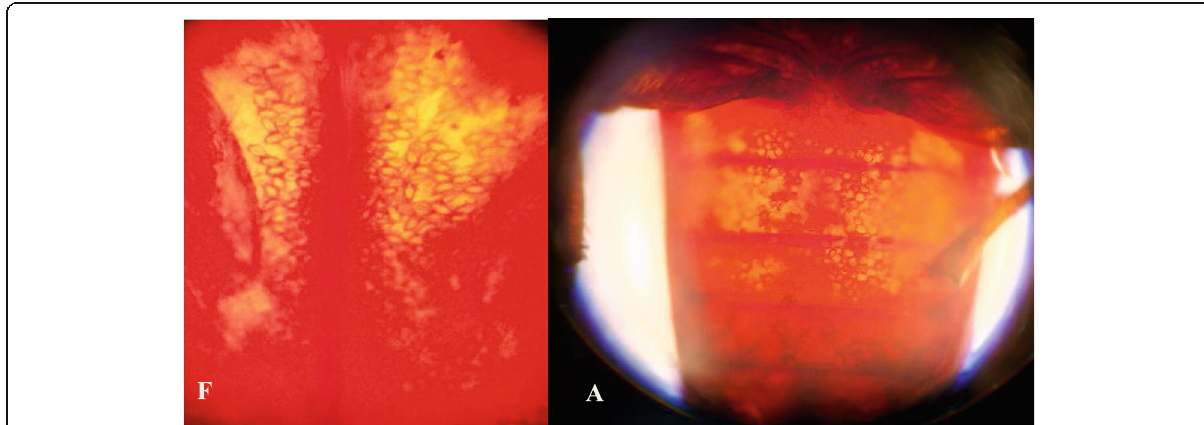
Fig. 7 Light microscope views of Farinocystis spores (F) and Adelina oocysts (A) distinctly seen via the sternites of Tribolium castaneum beetle (×100 to ×400 magnification)